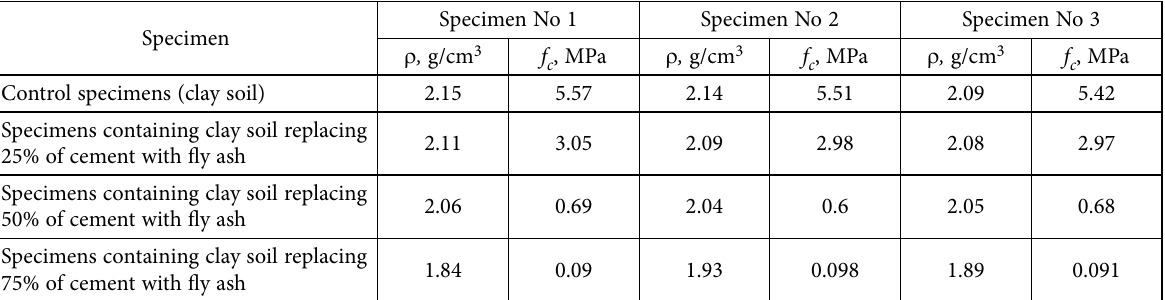
Table 3. The results of experiments on soilcrete containing the additives of fly ash in clay soil following 7 days of hardening